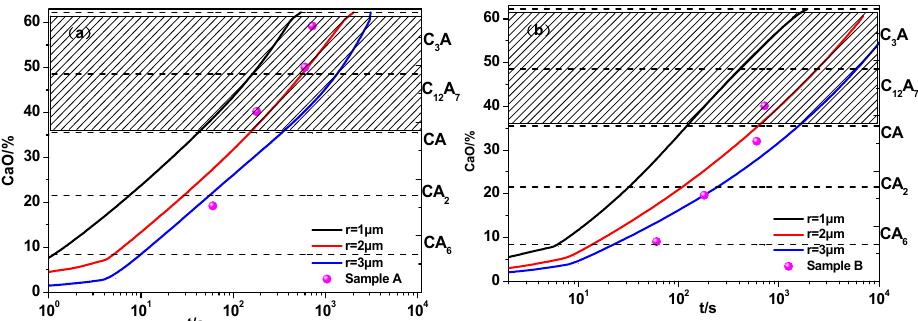
Figure 13. Variation of CaO contents in inclusions with time: ( a ) sample A; ( b ) sample B.